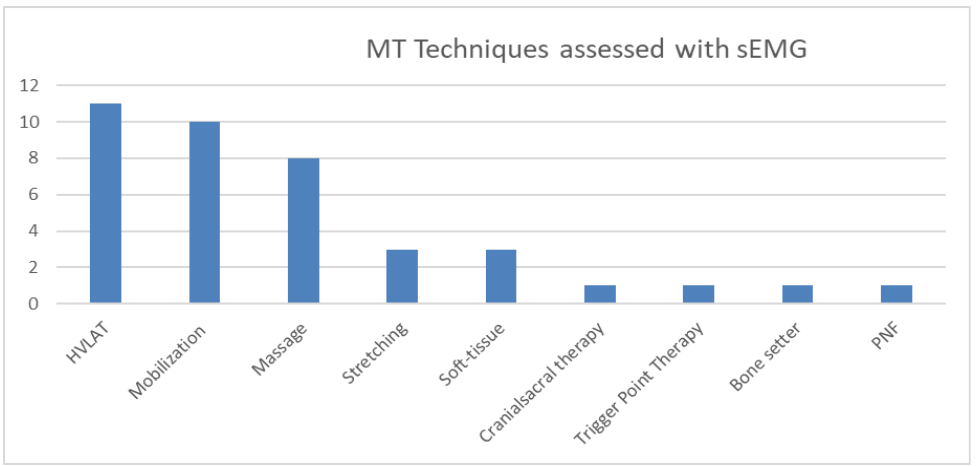
Figure 1. MT Techniques assessed with sEMG.